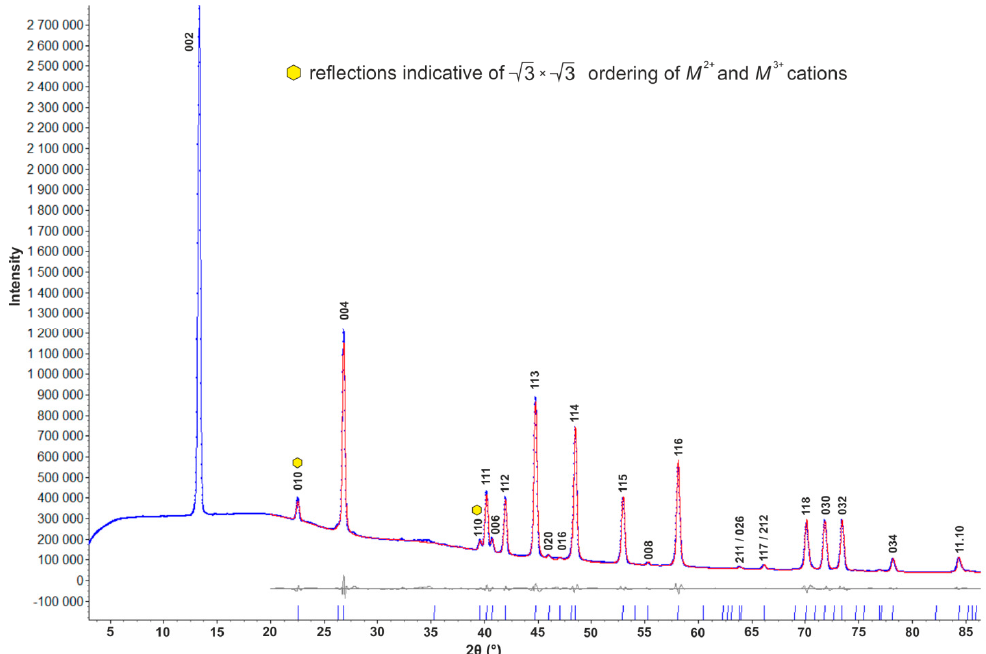
Figure 5. Indexed powder XRD pattern of chlormagaluminite: Pawley fit between experimental (blue) and calculated (red) lines. The reported here structure model is applied; superstructure reflections are marked.